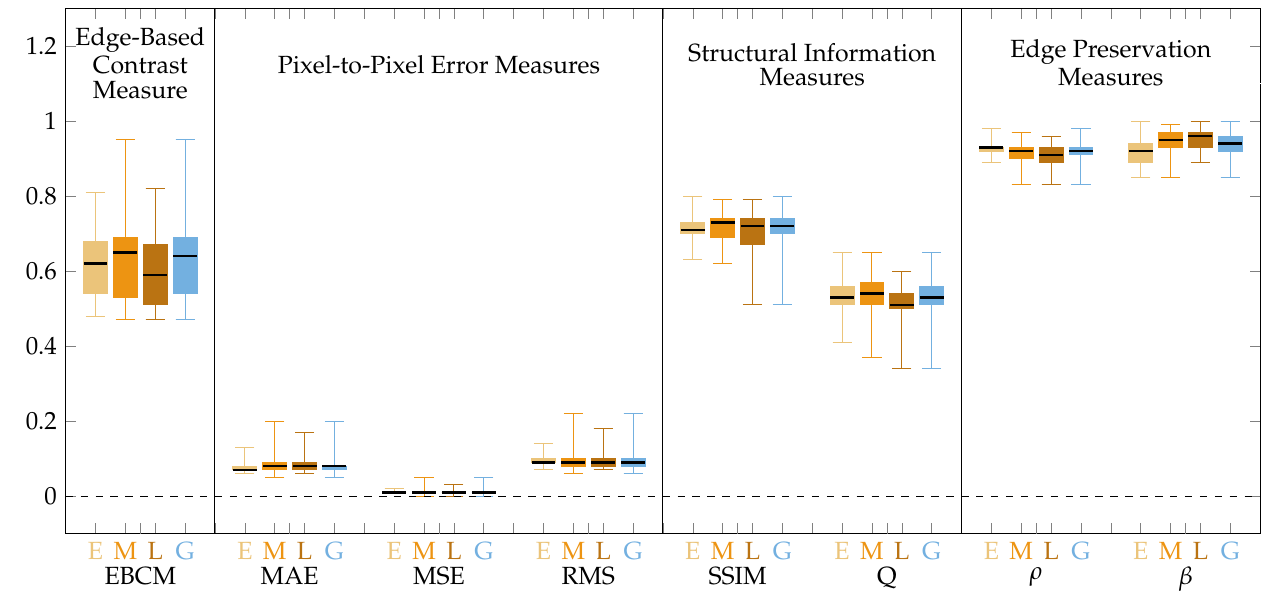
Figure 7. Quality measures for images processed by the CLAHE method.Measure values calculated for the central image regions only.